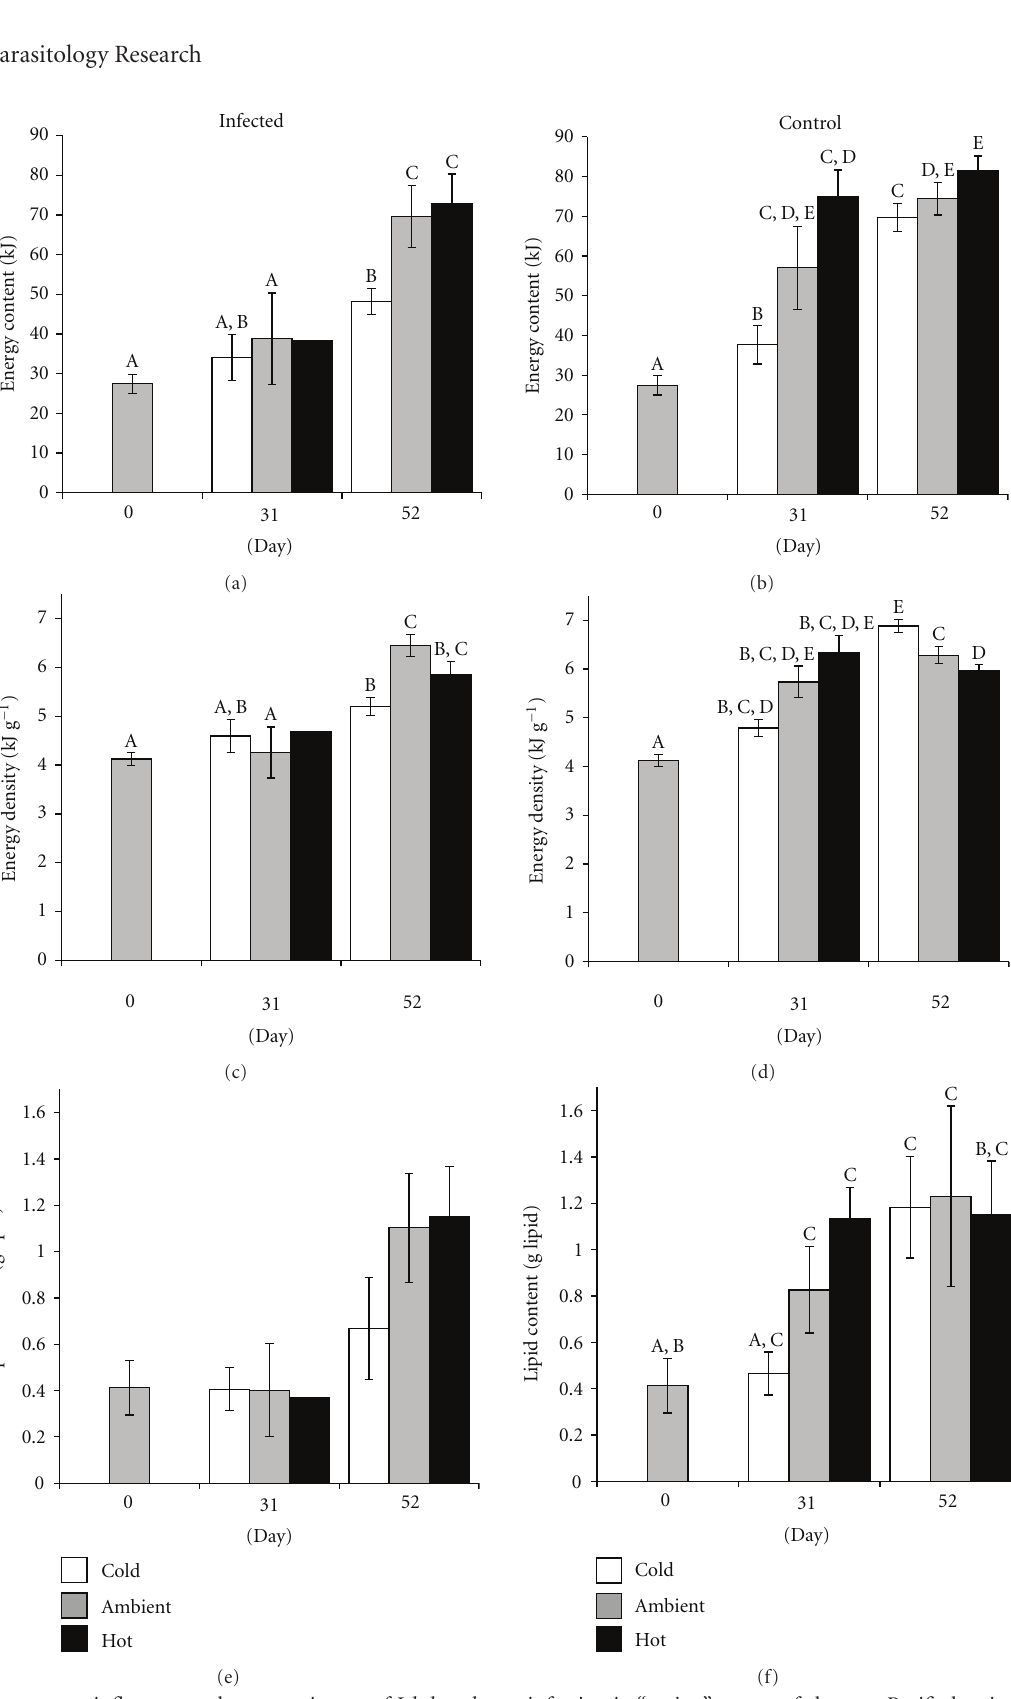
Figure 4: Temperature influence on the energetic cost of Ichthyophonus infection in “spring” young-of-the-year Pacific herring depicted by total energy content, energy density, and lipid content (g lipid). Water temperatures were cold (9.5 ◦ C), ambient (12.0 ◦ C), and hot (15.0 ◦ C). Di ff erent letters within a panel represent statistical di ff erentiation. Lack of letters indicates no statistical di ff erentiation. Low sample size of infected fish on day 31 precludes statistical